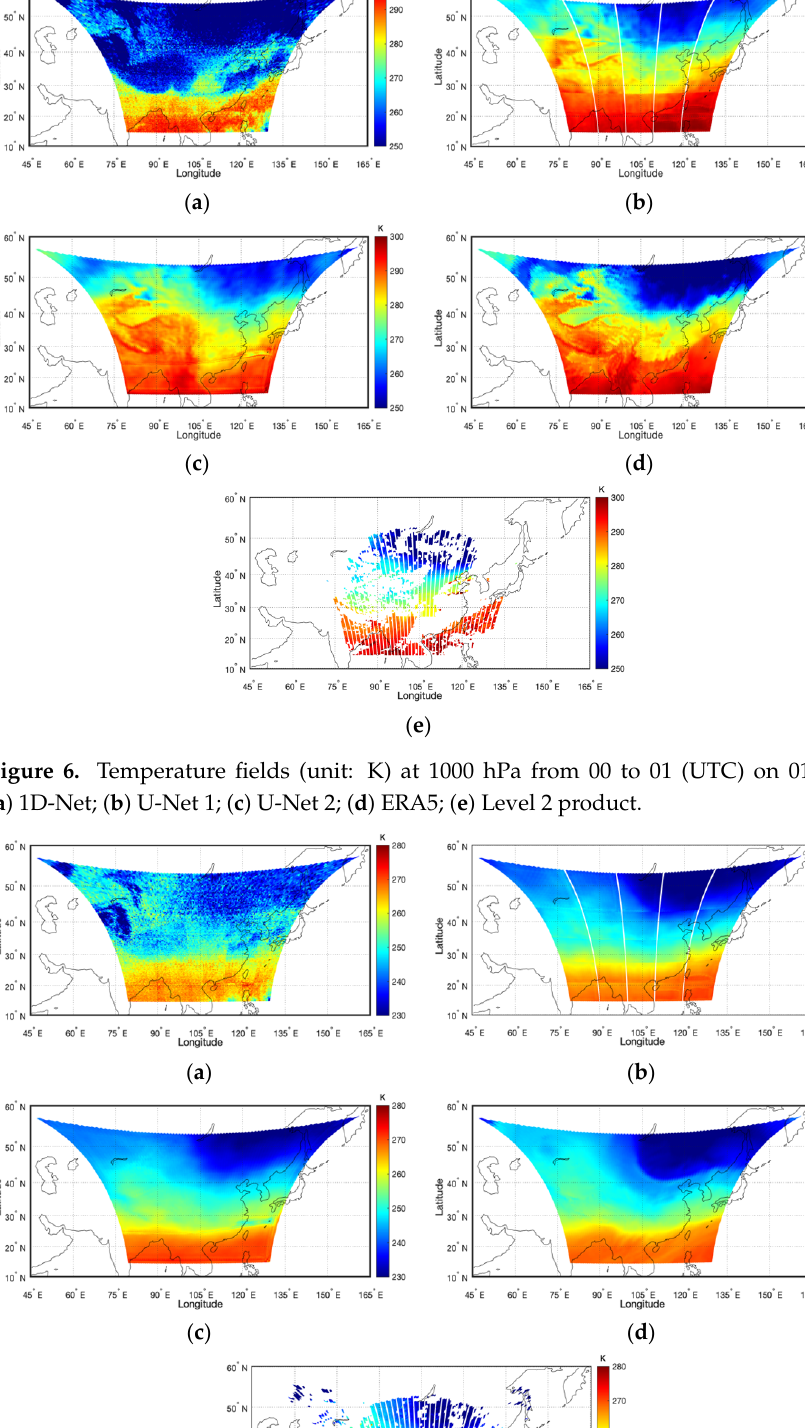
Figure 5. The GIIRS observed 900 cm (cid:2879) 1 brightness temperatures (unit: K) for the China area from 00 to 01 (UTC) on 01 February 2021.